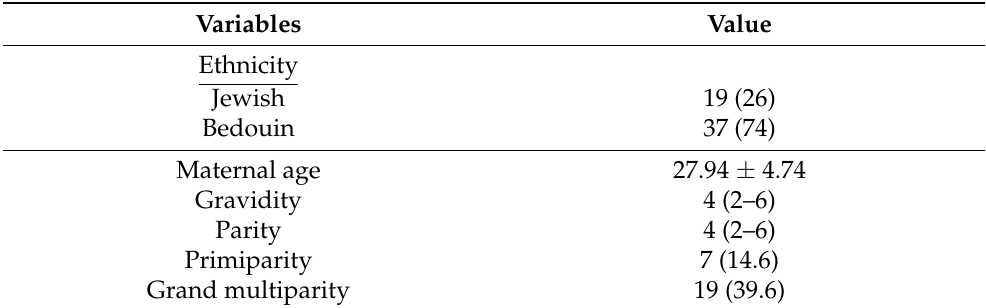
Table 1. Demographic characteristics for patients delivered following perforation of uterus.